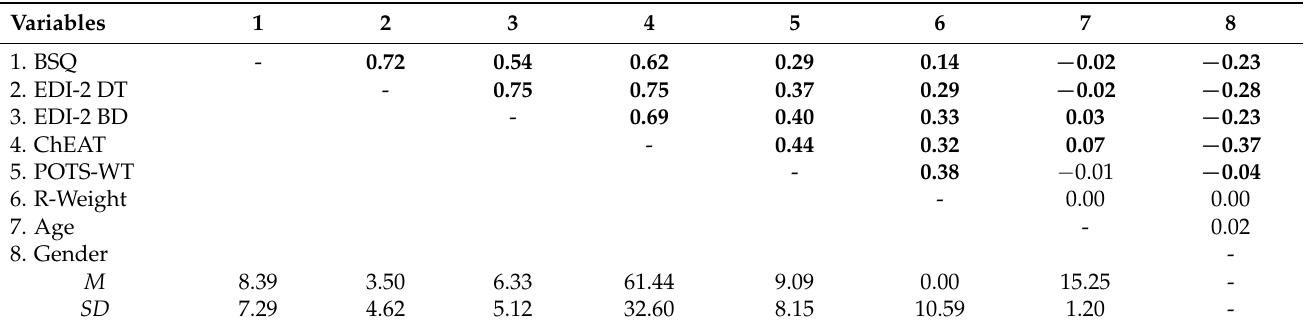
Table 1. Descriptive statistics and correlations among the variables of the study in the adolescent sample.